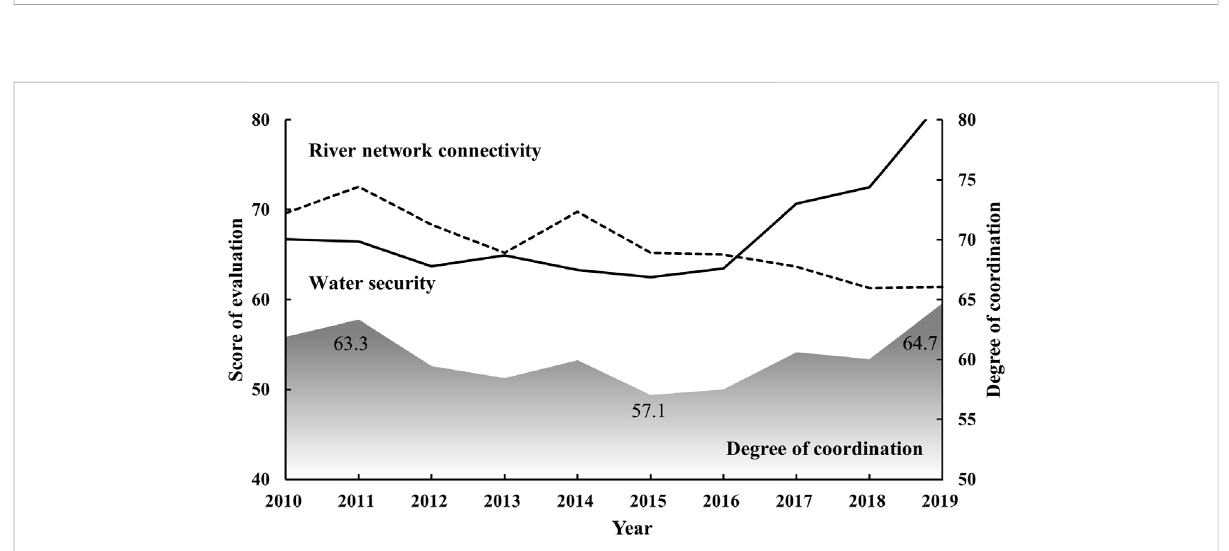
FIGURE 7 Composite evaluation results of river network connectivity, water security, and degree of coordination from 2010 to